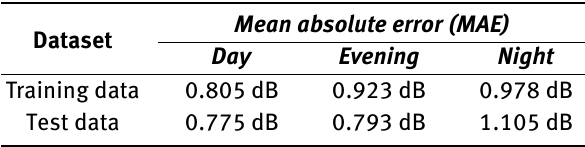
was used to predict the values of L (Figure 4).